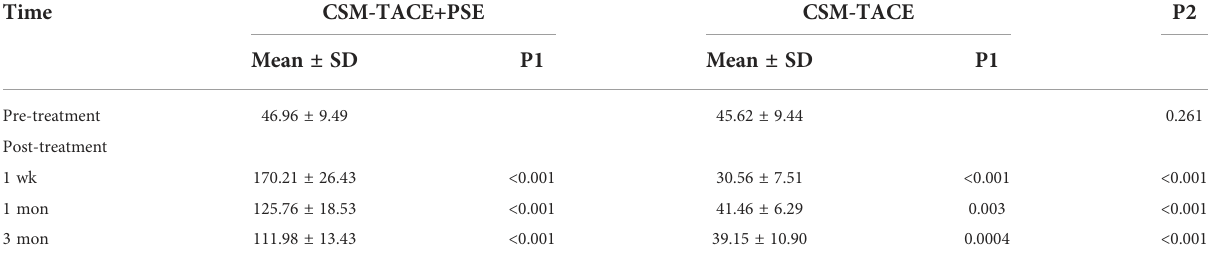
TABLE 4 Follow-up results of platelet (PLT) counts (×10 12 /L).